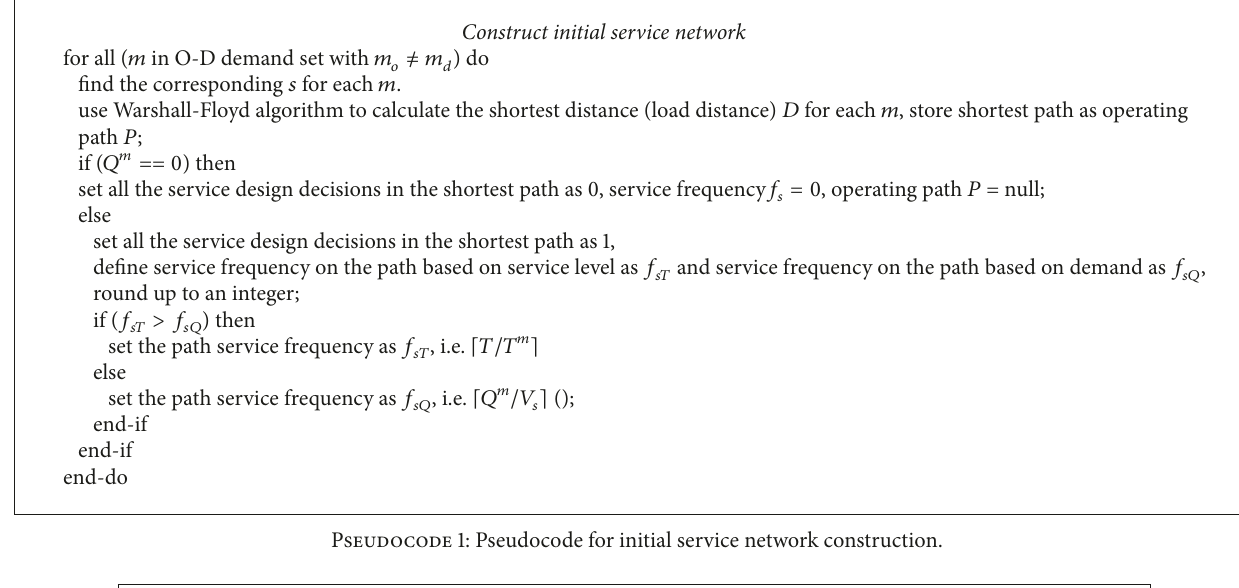
Construct initial service network